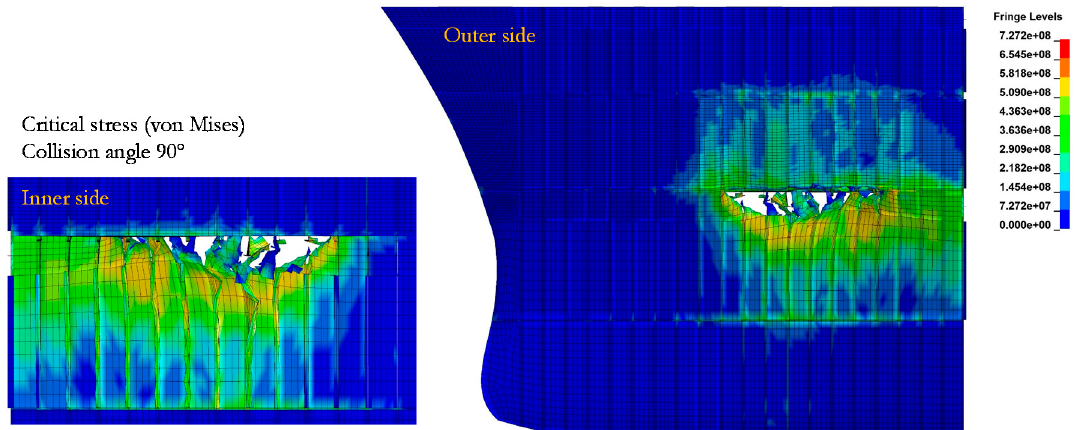
Figure 14. Critical stress (von Mises formulation) of the collision angle 90°.